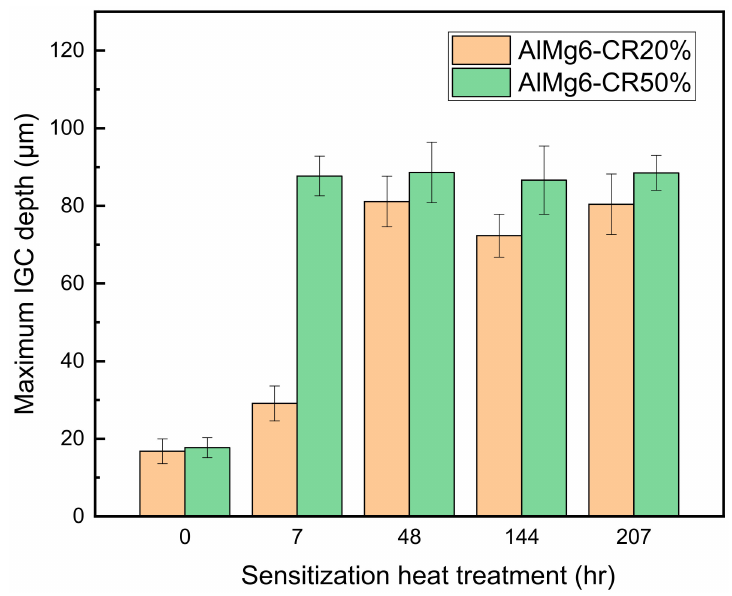
Figure 8. Maximum IGC depths of CR20 and CR50